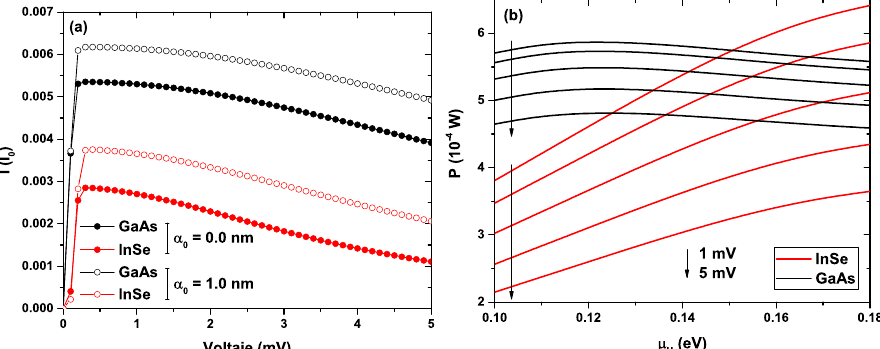
Figure 9. In ( a ), the electronic tunneling current for the well-barrier lattice system as a function of the bias voltage, in units of I 0 = 2 e / h , for zero ILF-parameter (full symbols) and α 0 = 1.0nm (open symbols). In ( b ), the power for five different bias voltages concerning the chemical potential of the hot reservoir. The width of the wells and the two central barriers has been set at 5nm and the two lateral barriers at 2.5nm (see Figure 2(c3)). Calculations are for GaAs-Al 0.3 Ga 0.7 As and InSe-InP